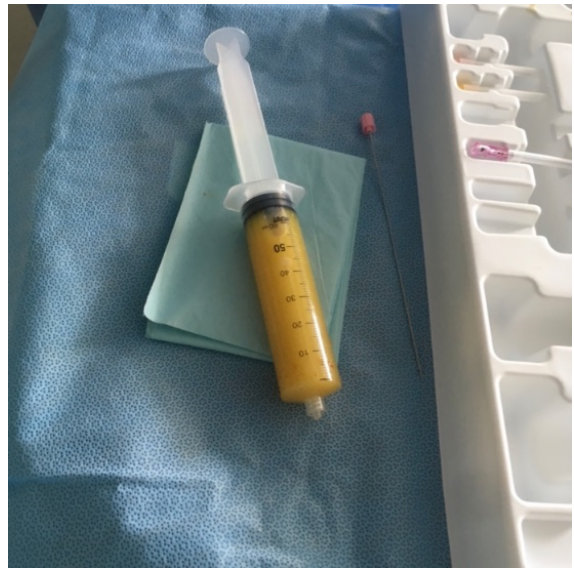
Figure 4. Pericardial punctate with thick yellowish pus.